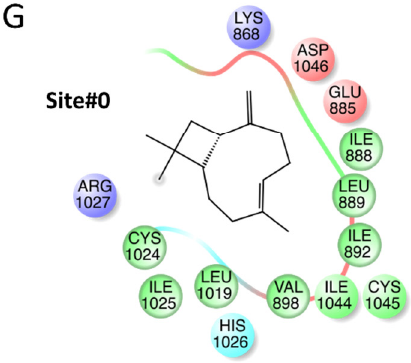
Figure 3. BCP has a binding site on the surface of VEGFR2 based on computational structural analysis: summary of the computational analyses performed in the current study. ( A , B ) represent the 3- & 2-dimensional ligand interaction diagrams, respectively, of the co-crystallized ligand, Sorafenib, with the kinase domain of VEGFR2 (PDB code: 3WZE). A pie chart representing potential BCP binding sites occupancies, obtained through clustering the full 1.4 µ s accelerated MD trajectory ( C ). Representative conformations of BCP within these sites were given in figure ( D ) and color-coded using the same scheme displayed in the pie chart. Each of these representative conformations was subjected to 100 ns MD classical MD simulations, and the corresponding AMBER/MM-GBSA binding energy data was given in figure ( E ); again, with the same color codes of Figures ( C , D ). To enhance the clarity of the figures, we decided to depict the representative conformations and binding energies plots only for the top 6 clusters. Notably, Site#0 represents the most probable site of BCP, given the high fractional binding site occupancy and the better binding affinity compared to other sites. The RMSD plots presented in Figure ( F ) of the classical trajectory of BCP bound to Site#0 show stable trajectories for the ligand, and the receptor, a 2D ligand interaction diagram of BCP within Site#0 was given in Figure ( G